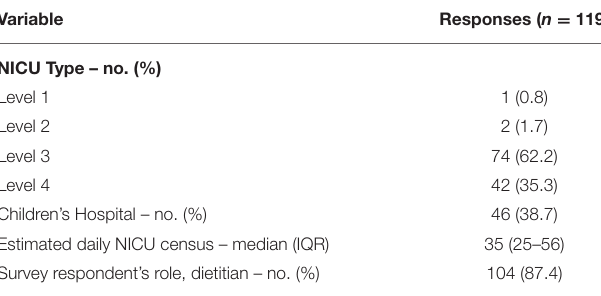
TABLE 2 | Demographic information of survey responses.